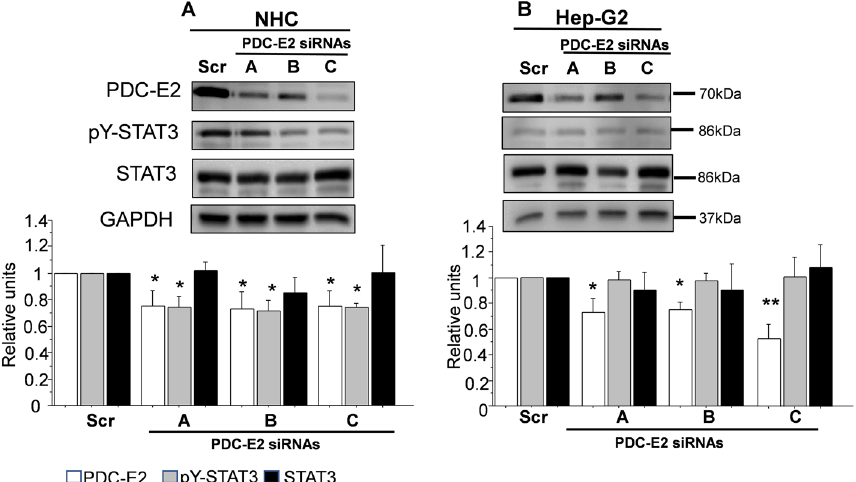
Figure 3. Gene silencing of PDC-E2 reduces p-STAT3 level in NHC cells. Western blot analysis of PDC-E2, pY-STAT3 and STAT3 protein levels in NHC (A) and Hep-G2 (B ) cells treated with three siRNAs ( A , B , C ) to silence PDC-E2 or a scrambled (scr) siRNA. Results are representative of three independent experiments. ** p < 0.01, * p <